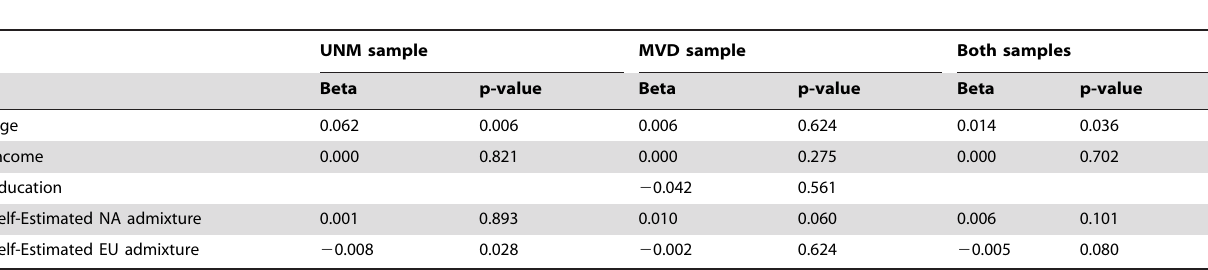
Table 2. Multiple regression with error score as the outcome variable, for each sample separately, and for both samples together.